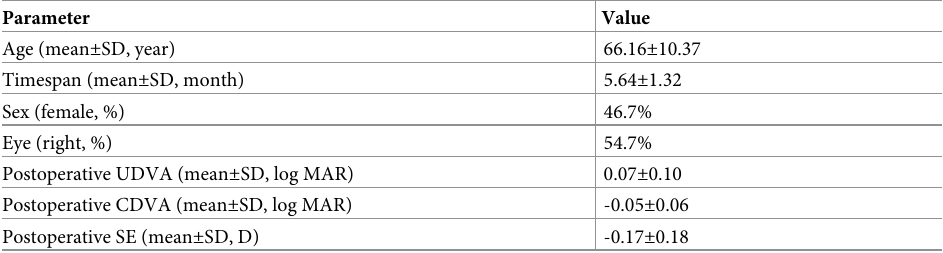
Table 1. Study population characteristics.